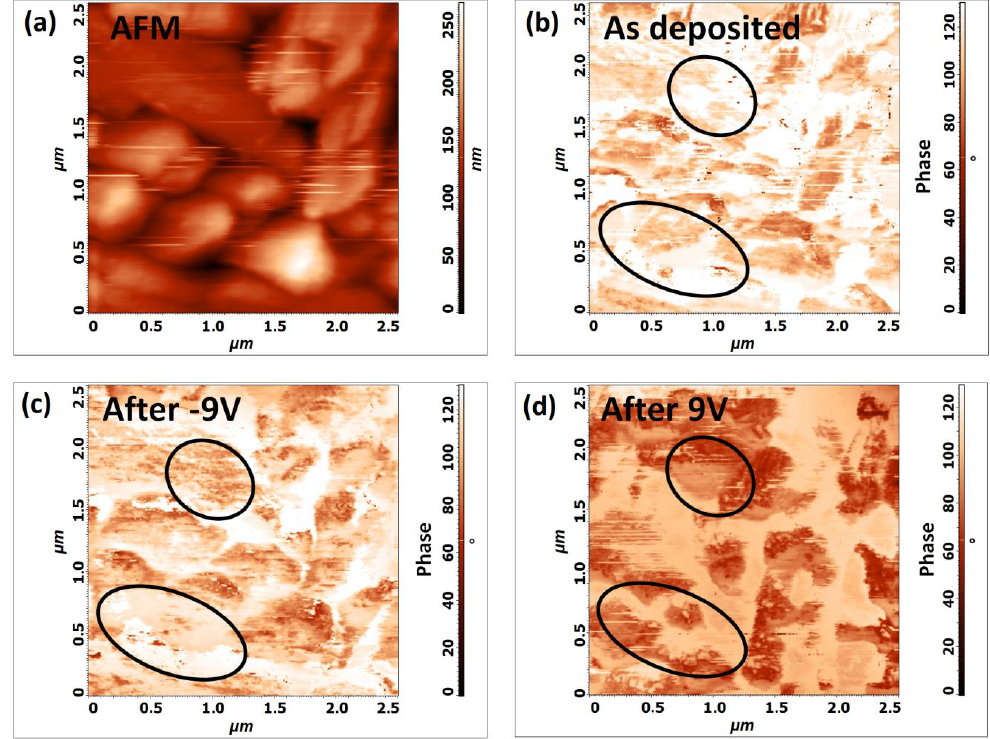
Figure 6. Ferroelectric domains switching: ( a ) AFM image of the scanned 2.5 µm × 2.5 µm area and ( b ) phase scan of the “as deposited” BFO film; ( c ) phase scan of the BFO film after the application of a − 9